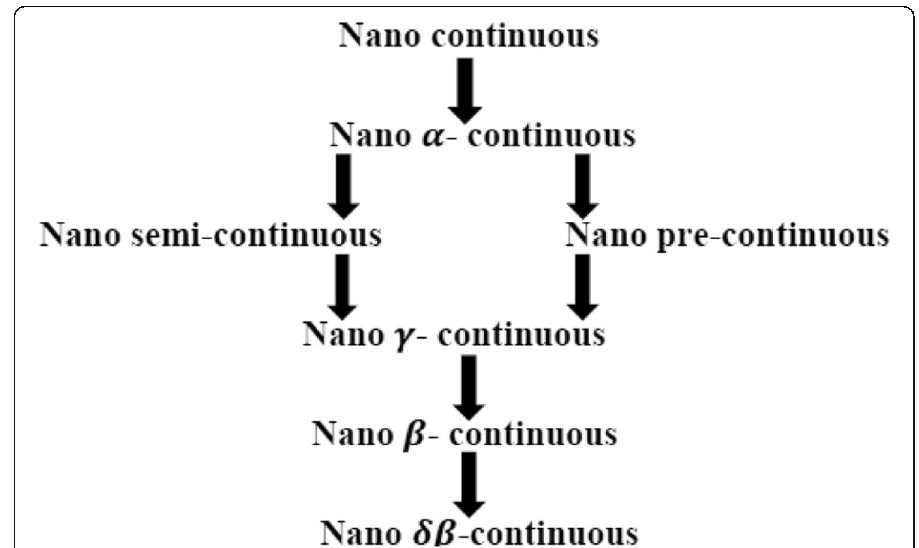
Fig. 2 The relationships between near nano continuous